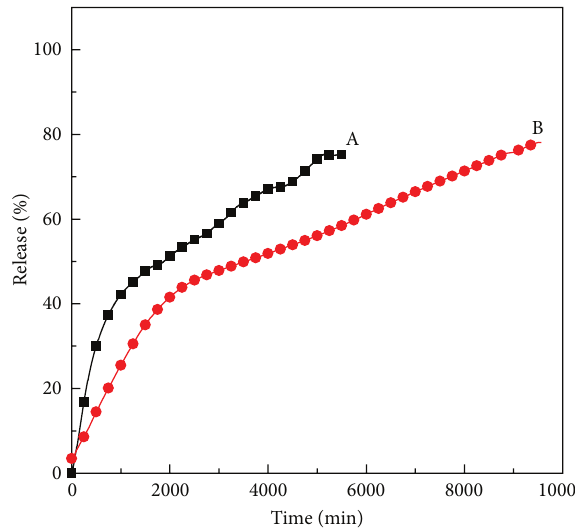
Figure 7: Release profiles of dopa from the Tween-dopa-LDH nanocomposite at pH 4.8 (A) and pH 7.4